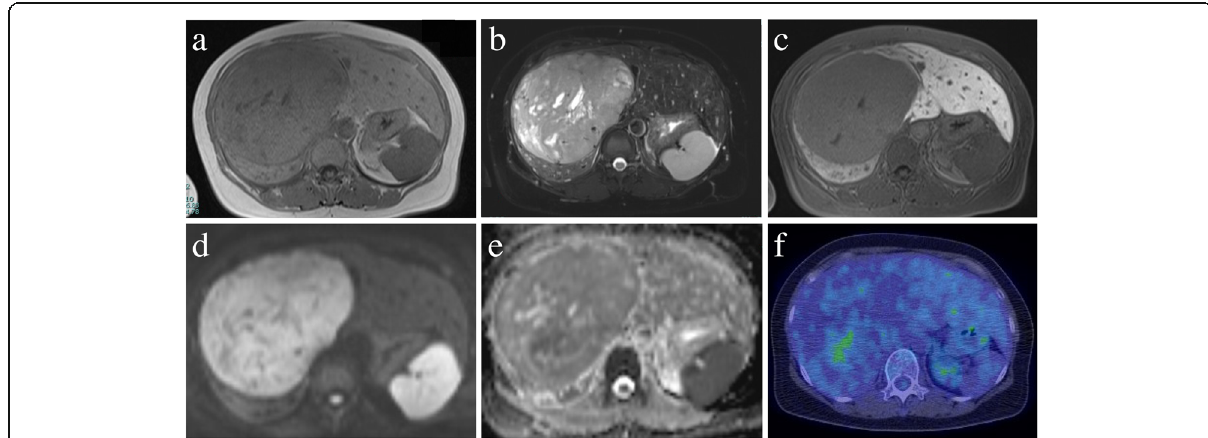
Fig. 2 Magnetic resonance imaging (MRI) and [ 18 F]-fluorodeoxyglucose positron emission tomography (FDG-PET). Abdominal MRI shows low intensity on a T1-weighted image ( a ) and heterogeneously high or iso intensity on a T2-weighted image ( b ). Gadolinium-ethoxybenzyl- diethylenetriamine pentaacetic acid-enhanced MRI reveals a hypointense mass during the hepatobiliary phase ( c ). Diffusion-weighted imaging shows higher intensity than for normal liver parenchyma ( d ) with a high b value of 1000 ( e ). FDG-PET shows no accumulation of [ 18 F]-FDG ( f )